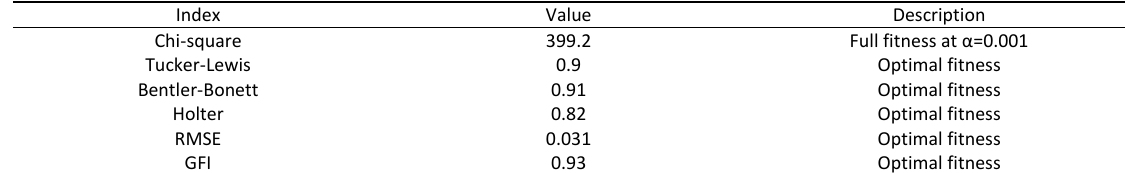
Table 7: The indexes of the fitness of the path model